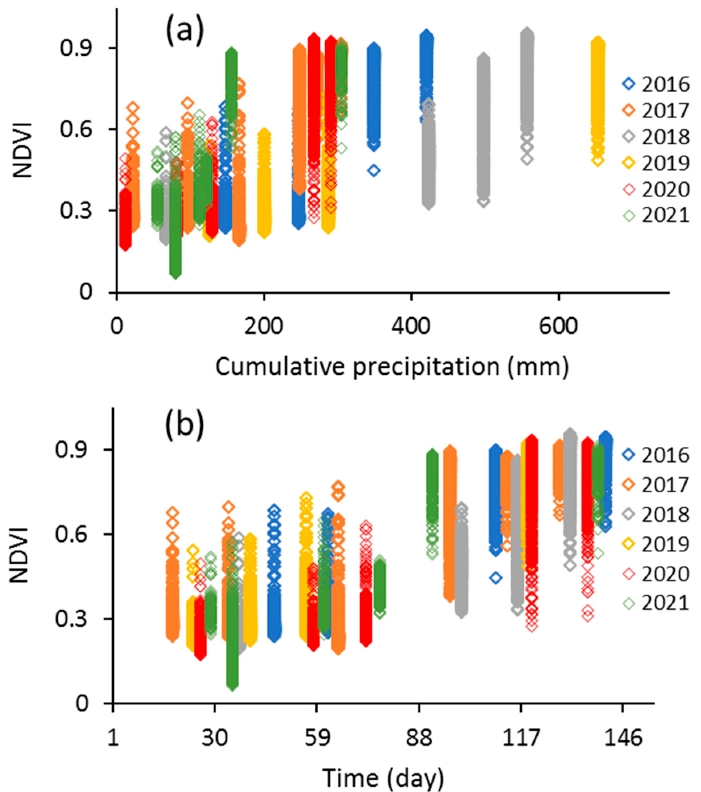
Figure 4. NDVI data (from soybean, corn, and wheat in rotation) vs. time ( a ) and precipitation ( b ) from April to August in different years at all pixels. Table 2. Descriptive statistics of NDVI data for the month of July (2016–2021).